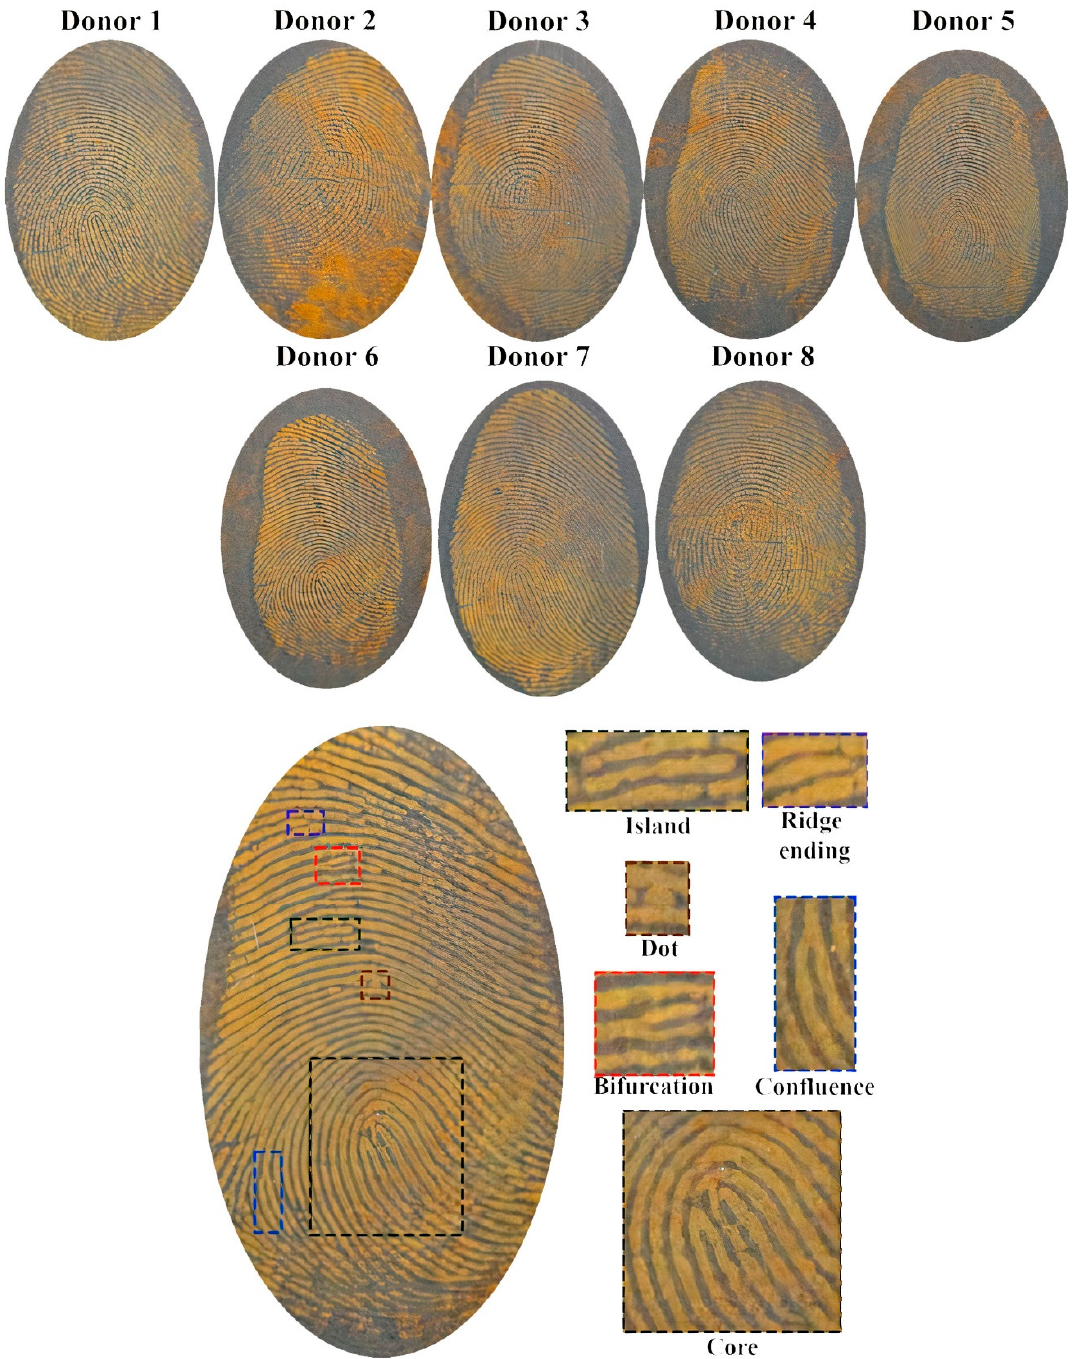
Figure 2. Fingermark development using RHL/chalcone as dusting powder and their identification of minutiae . of